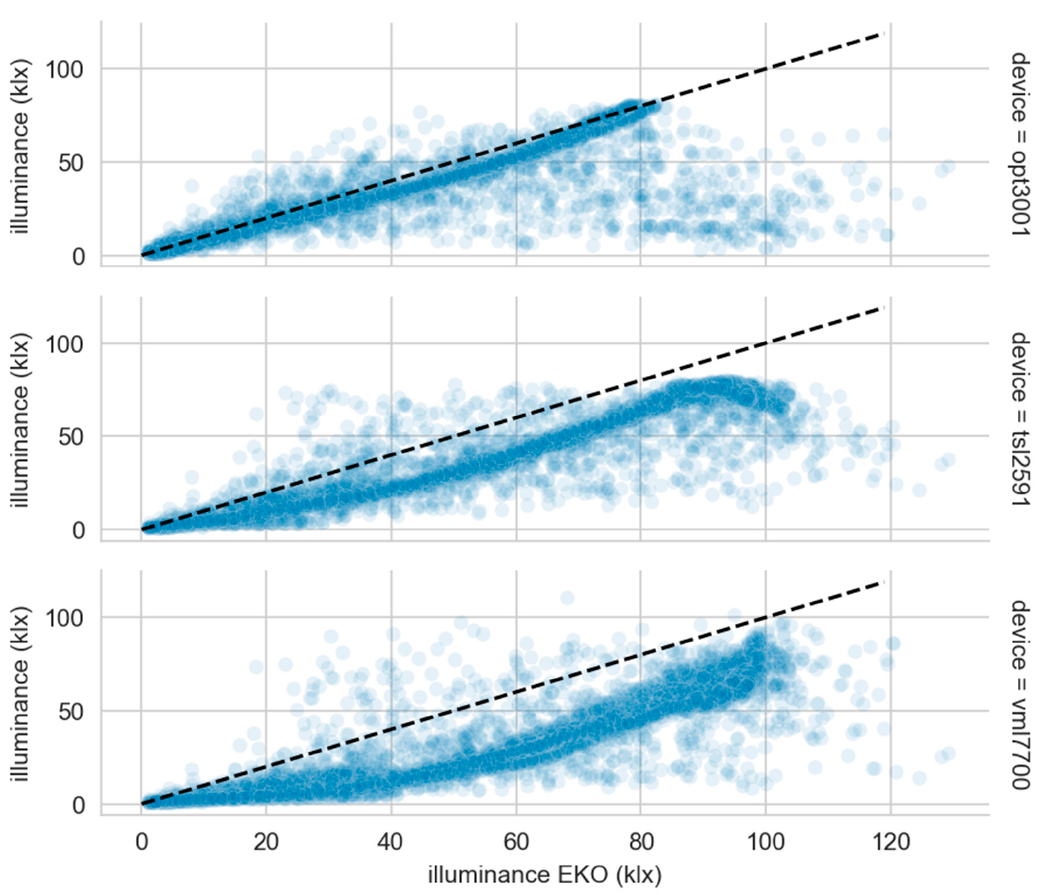
Figure 10. Illuminance low-cost sensor measurements versus professional one.